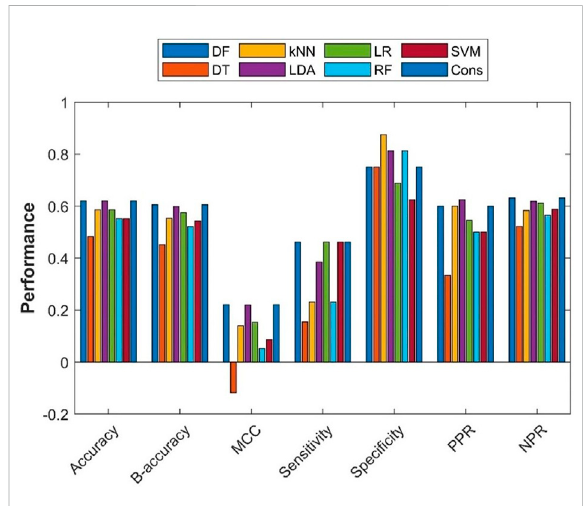
FIGURE 6 External validation results. The x -axis indicates performance metrics, while the y -axis gives values of the performance metrics. Machinelearningalgorithmswerecolorcodedbythecolorlegend above the fi gure.